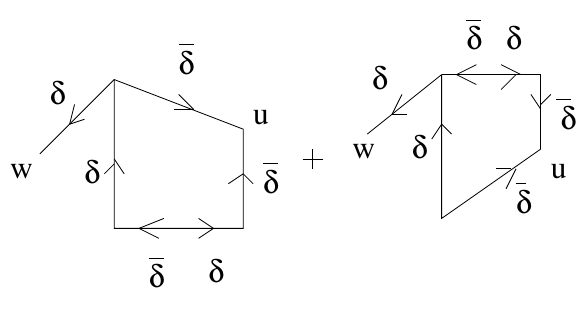
Figure 12 . Skeleton graphs for (cid:8) 12 ;B